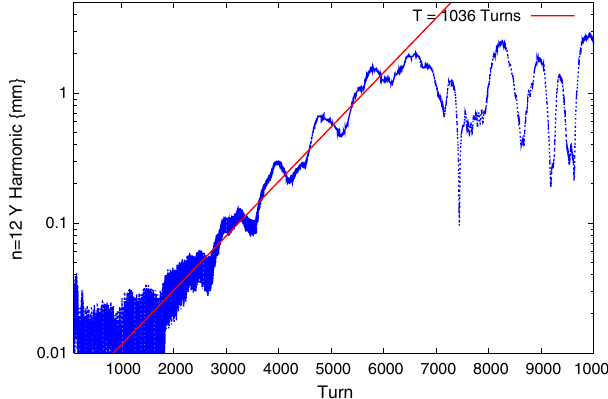
FIG. 8. Vertical n ¼ 12 harmonic (in blue) versus turn number in the ORBIT extraction kicker instability simulation. The red line depicts an exponential growth time of 1036 turns.